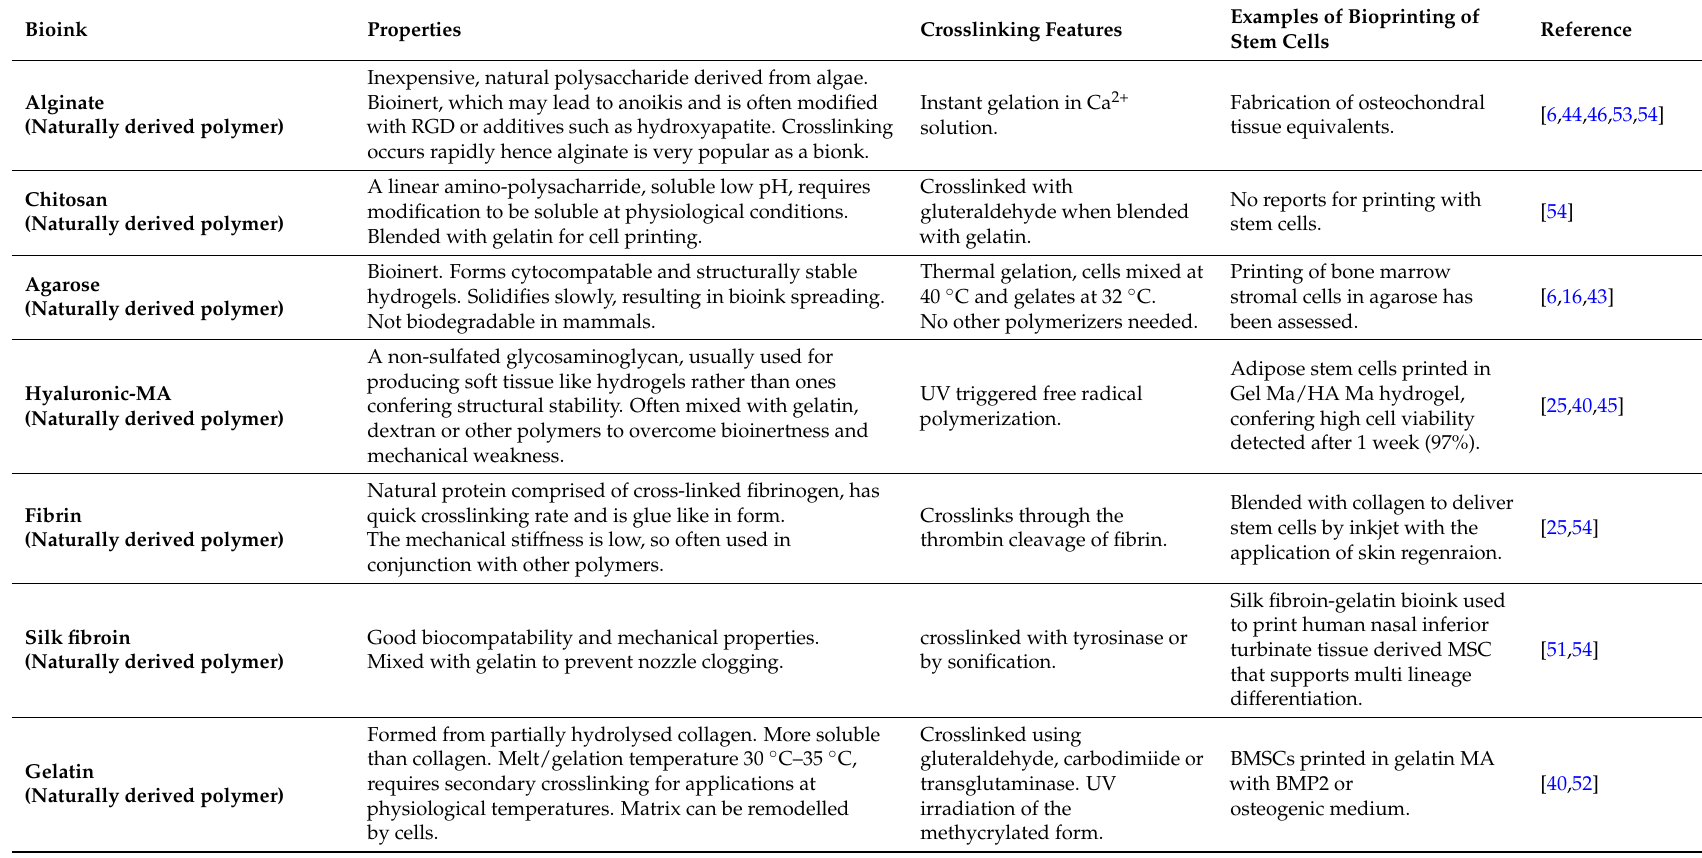
Table 2. Biocompatible polymers used as bioinks for stem cell delivery are presented along with their crosslinking features and application in bioprinting stem